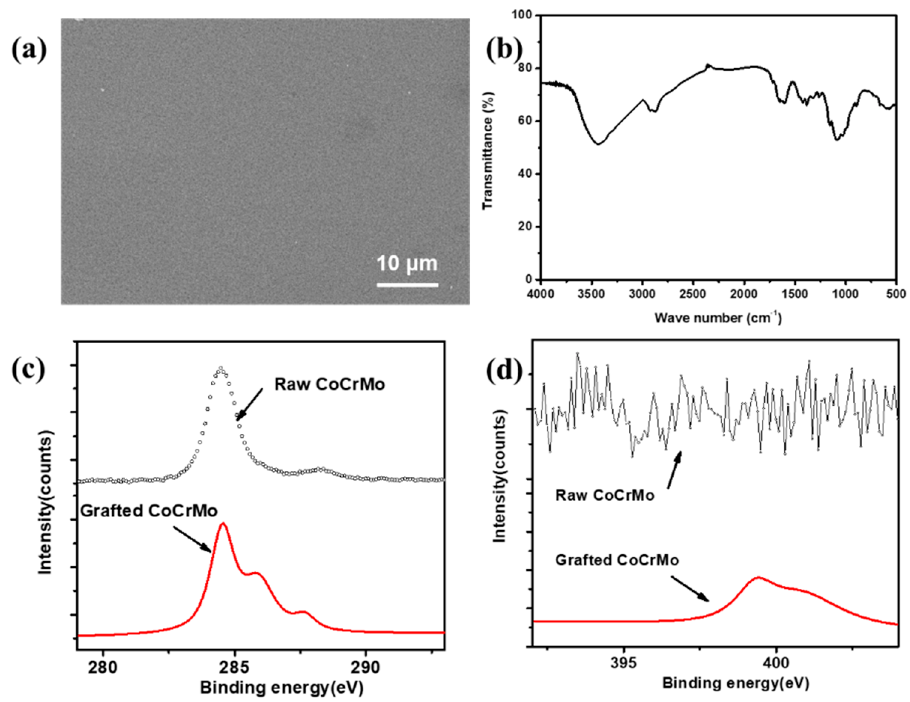
Figure 4. Surfaces grafted with CS brushes: ( a ) SEM morphology, ( b ) FTIR, ( c ) high-resolution spectrum of C1s, and ( d ) the high-resolution spectrum of N1s.